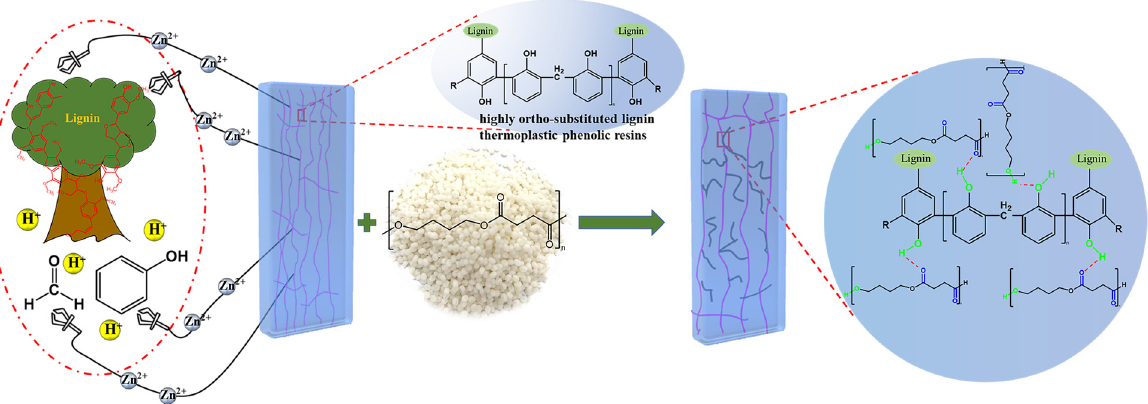
Figure 1. Modulation of highly ortho-substituted lignin thermoplastic phenolic resins and the PBS toughening mechanism.